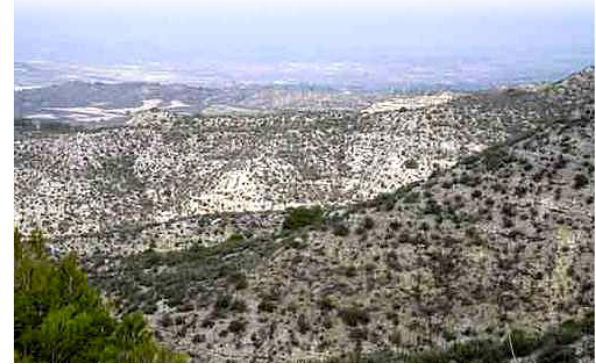
Figure 3. View of Los Monegros landscape.